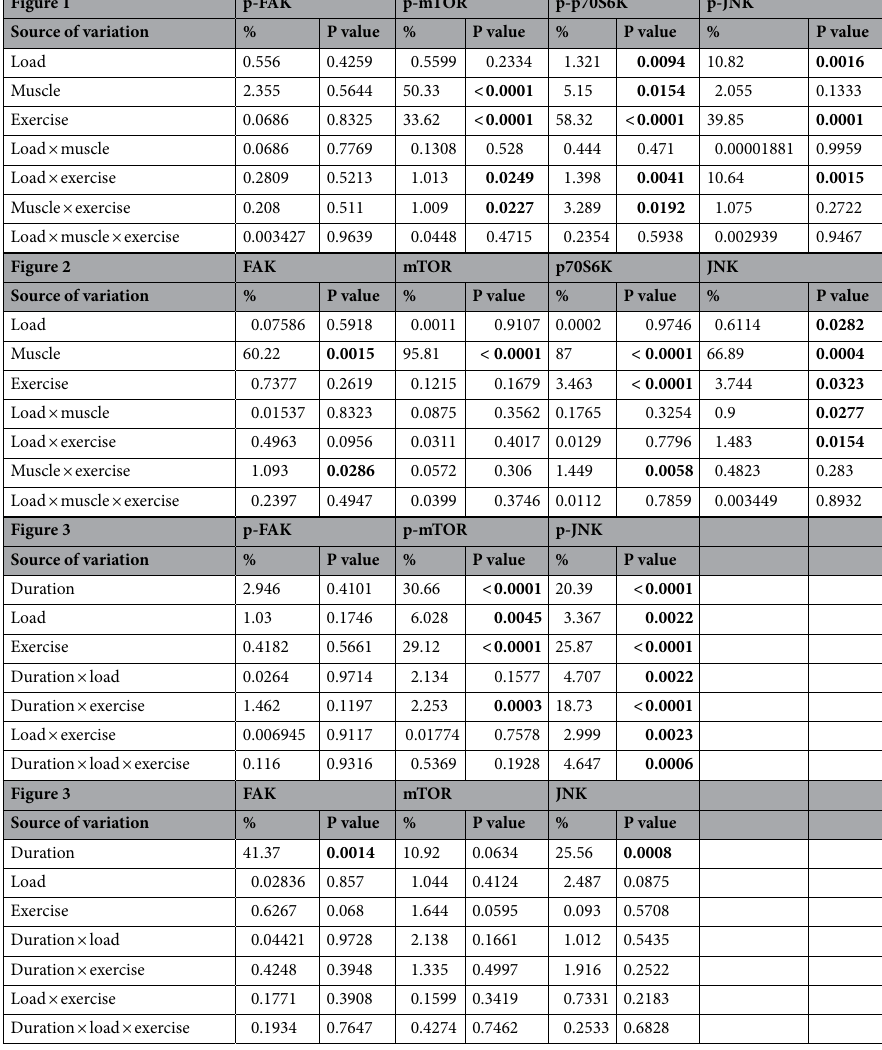
Table 1. Three-way ANOVA for the factors exercise, load and muscle type (corresponding to Figs. 1 and 2), or exercise, load and exercise duration (corresponding to Figs. 3 and 4), showing percent of total variation and corresponding p-value for the respective factors and interactions. P values < 0.05 highlighted in